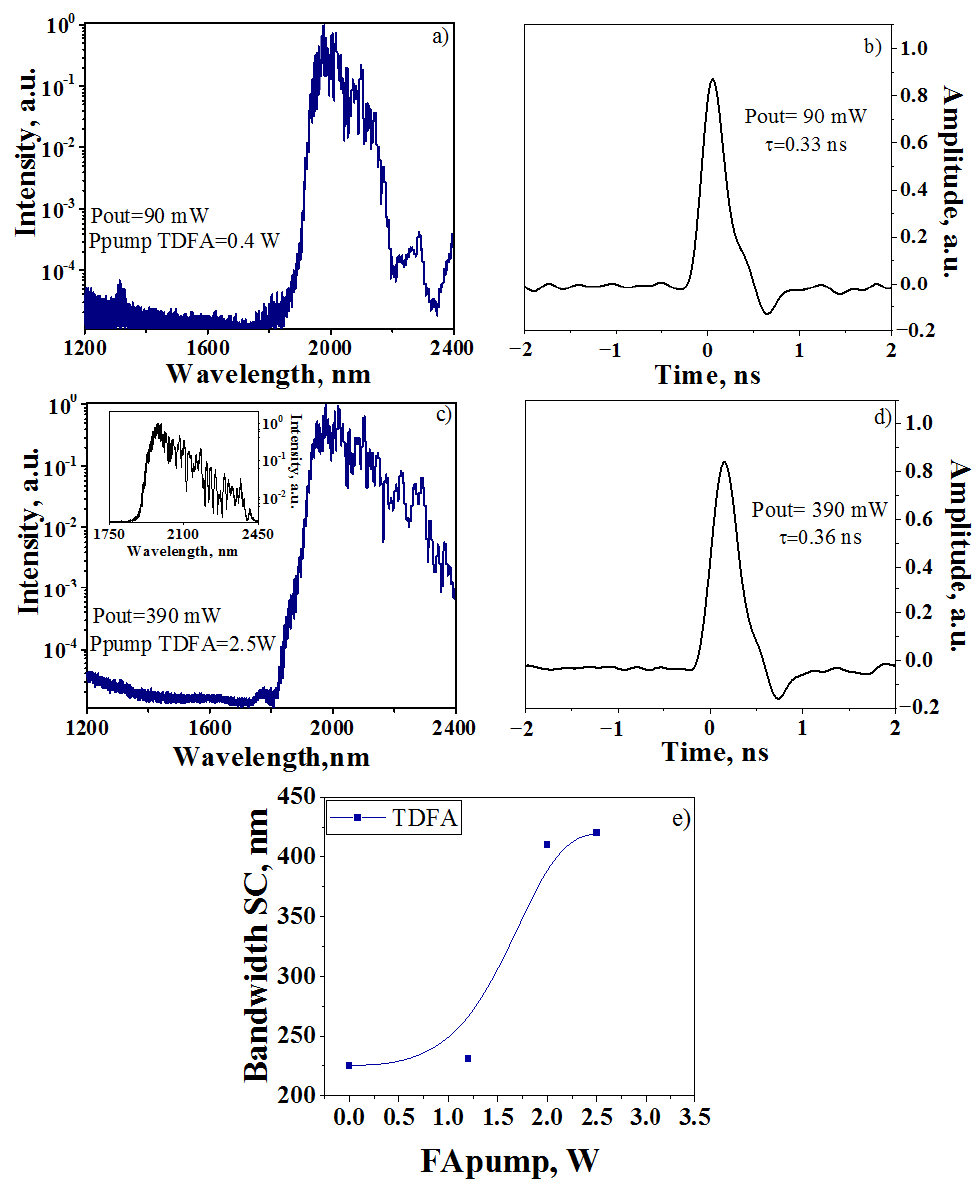
Figure 4. Spectral ( a , c ) and temporal ( b , d ) characteristics of radiation after Tm-doped FA at lower (top row) and higher (bottom row) pump power level. Graph ( e ) presents SC bandwidth vs. pump power. The inset at ( c ) shows the optical spectrum obtained with the Avesta spectrum analyzer for the same radiation parameters (resolution 1 nm).